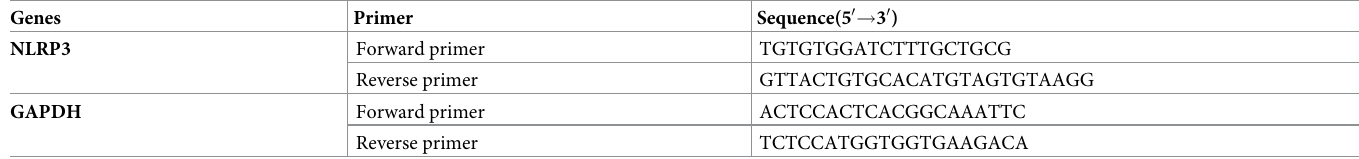
Table 1. The primers of quantitative RT-PCR.